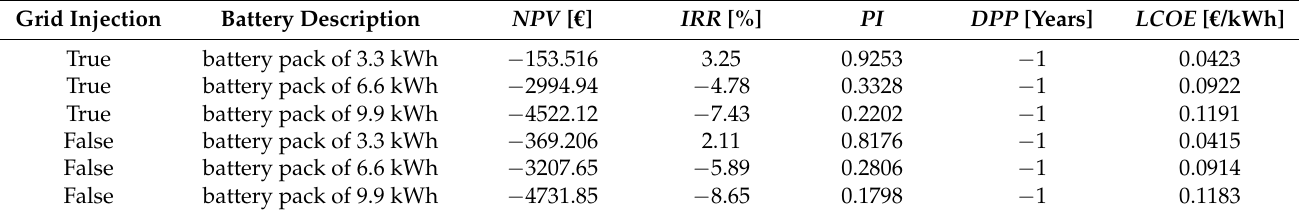
Table 10. Economical results for 0.5 kWp PV setup (individual battery packs).